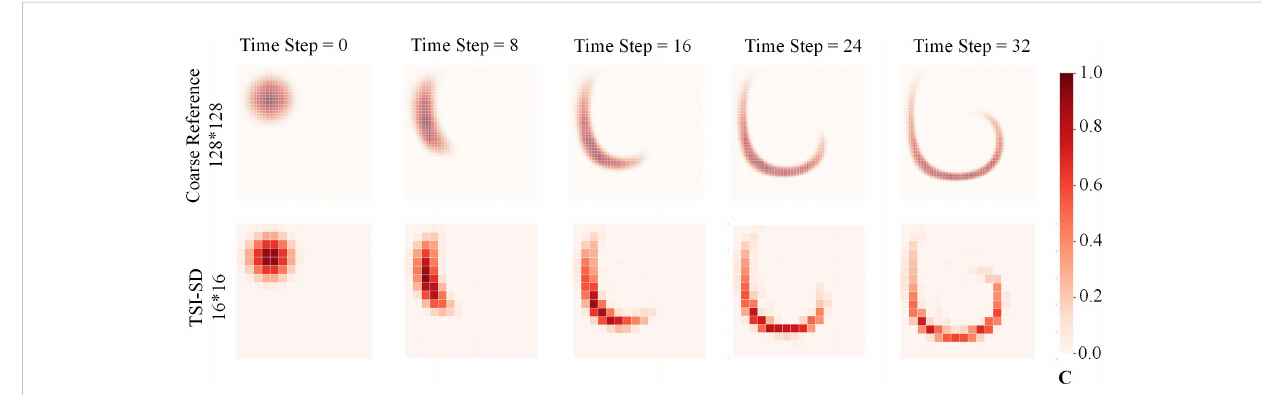
FIGURE 9 The predicted performance of our model in a deforming fl ow velocity fi eld. The fi rst row is the iterative solution of our 128*128 high-resolution solver after 32 time steps, and the second row is the iterative solution of our 16*16 solver after 32 time steps.